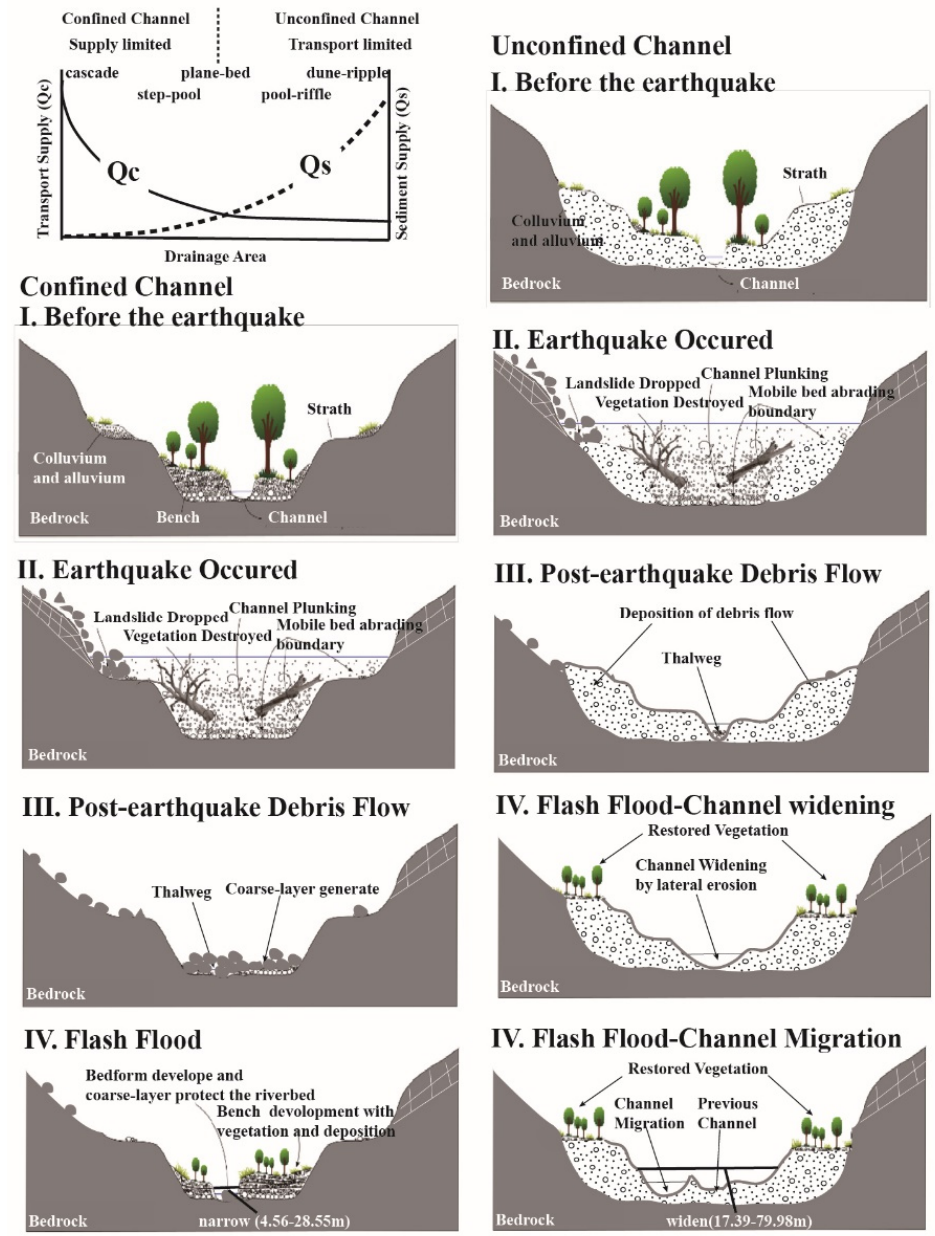
Figure 10. Conceptual diagram of the channel response to floods in an earthquake-affected catch- ment. The conceptual diagram for sediment transportation and supply was modified from [26,42].